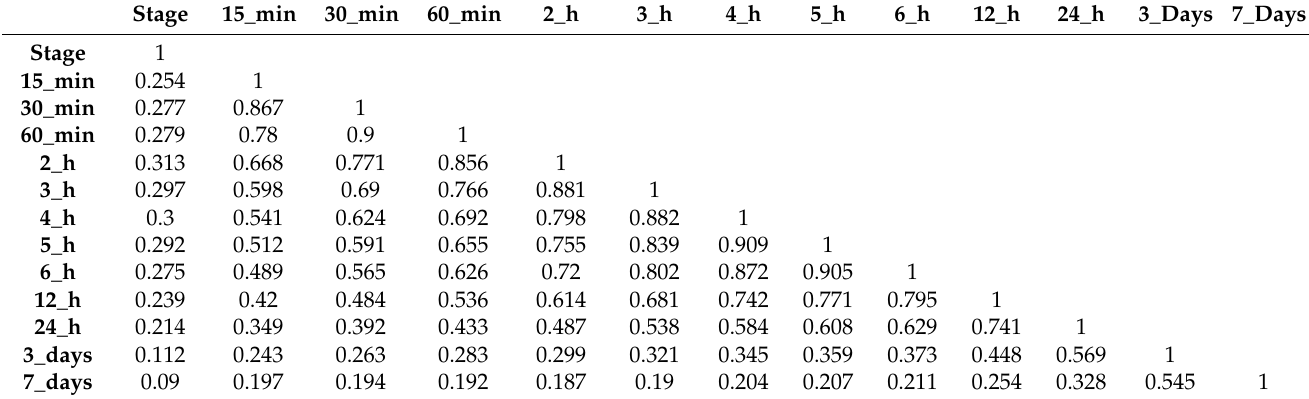
Table 1. Spearman correlation of precipitation and stage. All coefficients are significant at α = 0.01.